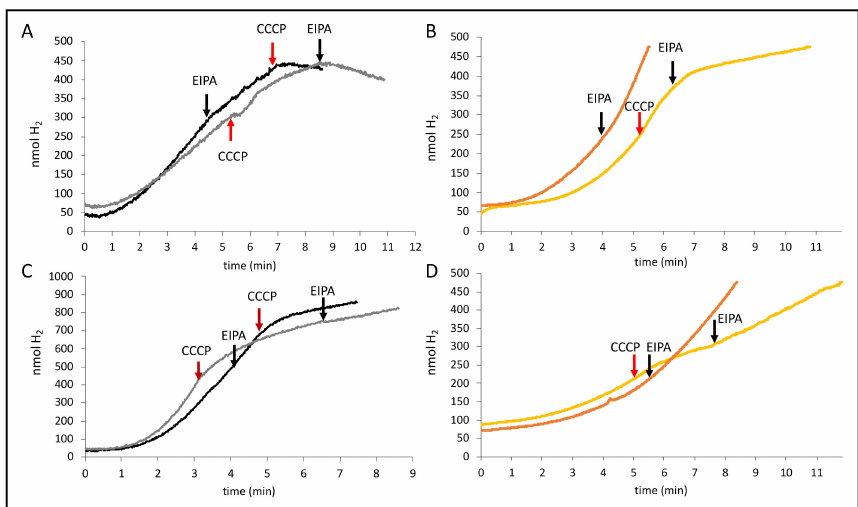
Figure 7. E ff ect of EIPA combination with CCCP. Cells of MC4100 (black, panels ( A ) and ( C )) or CP734 (orange, panels ( B ) and ( D )) were grown anaerobically in TGYEP, pH 6.5, and applied to the electrode as described in the Materials and Methods section. The reaction was initiated with glucose (top panels ( A ) and ( B )) or formate (bottom panels ( C ) and ( D )). Where indicated, 50 µ M CCCP (red arrows) or 50 µ M EIPA (black arrows) were added to the